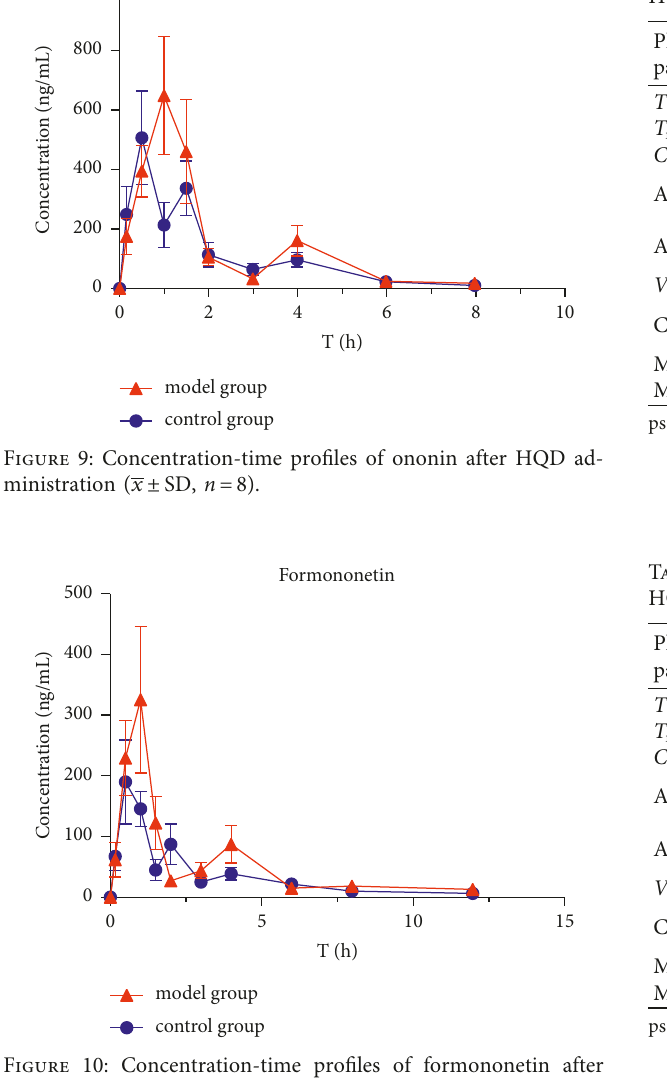
Table 6: The pharmacokinetic parameters of astragaloside IV after HQD administration.